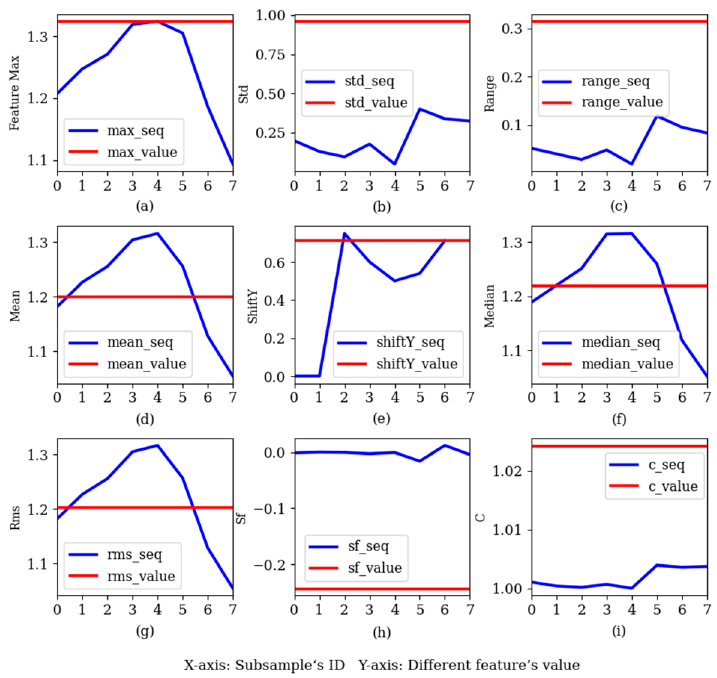
Figure 8. A comparison of the feature values in the AWS with the feature curves in the fine-grained samples. ( a ) Maximum, ( b ) standard deviation, ( c ) range, ( d ) average, ( e ) average fluctuation in pupil fixation in the vertical direction, ( f ) median, ( g ) root mean square, ( h ) skewness factor, ( i ) kurtosis factor.